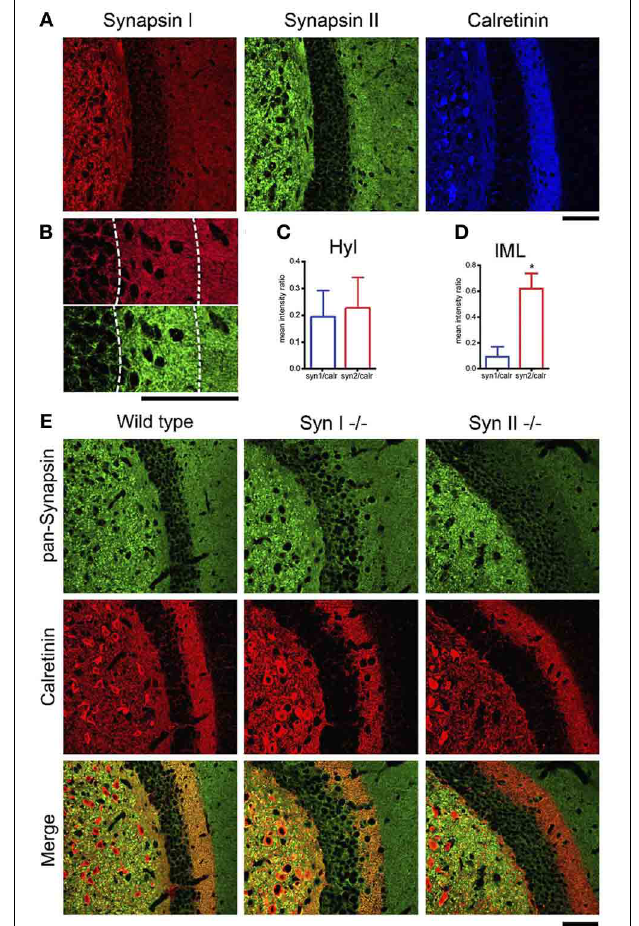
FIGURE 3 | SynII is highly colocalized with the mossy cell marker calretinin. (A) Representative images of the DG region in brain slices from 6 weeks old WT mice immunostained for Syn I, Syn II, and calretinin (scale bar 50 μ m); (B) Representative images of the inner molecular layer area (IML) of the DG immunostained for Syn I (upper panel) or Syn II (lower panel) (scale bar, 50 μ m); (C,D) Mean ( ± s.e.m.) ratios between Syn I/calretinin and Syn II/calretinin signals in the hilus (Hyl, C ) and inner molecular layer (IML, D ) of the DG. ∗ p < 0 . 05, two-tailed unpaired Student’s t -test. (E) Representative images of the DG region in brain slices from 6 weeks old WT (left column), Syn I − / − (middle column) or Syn II − / − (right column) mice immunostained for all synapsin isoforms (pan-Syn antibody) and calretinin. Right panels display the merge of the two signals (scale bar, 50 μ